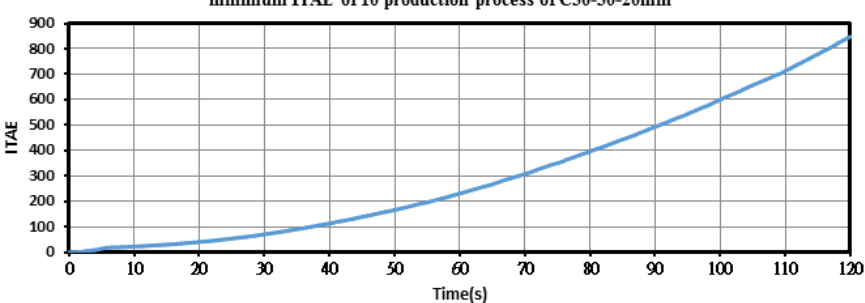
Figure 10. Minimum ITAE values for the PID–ZN controller when producing C30-30-20 min colloids.